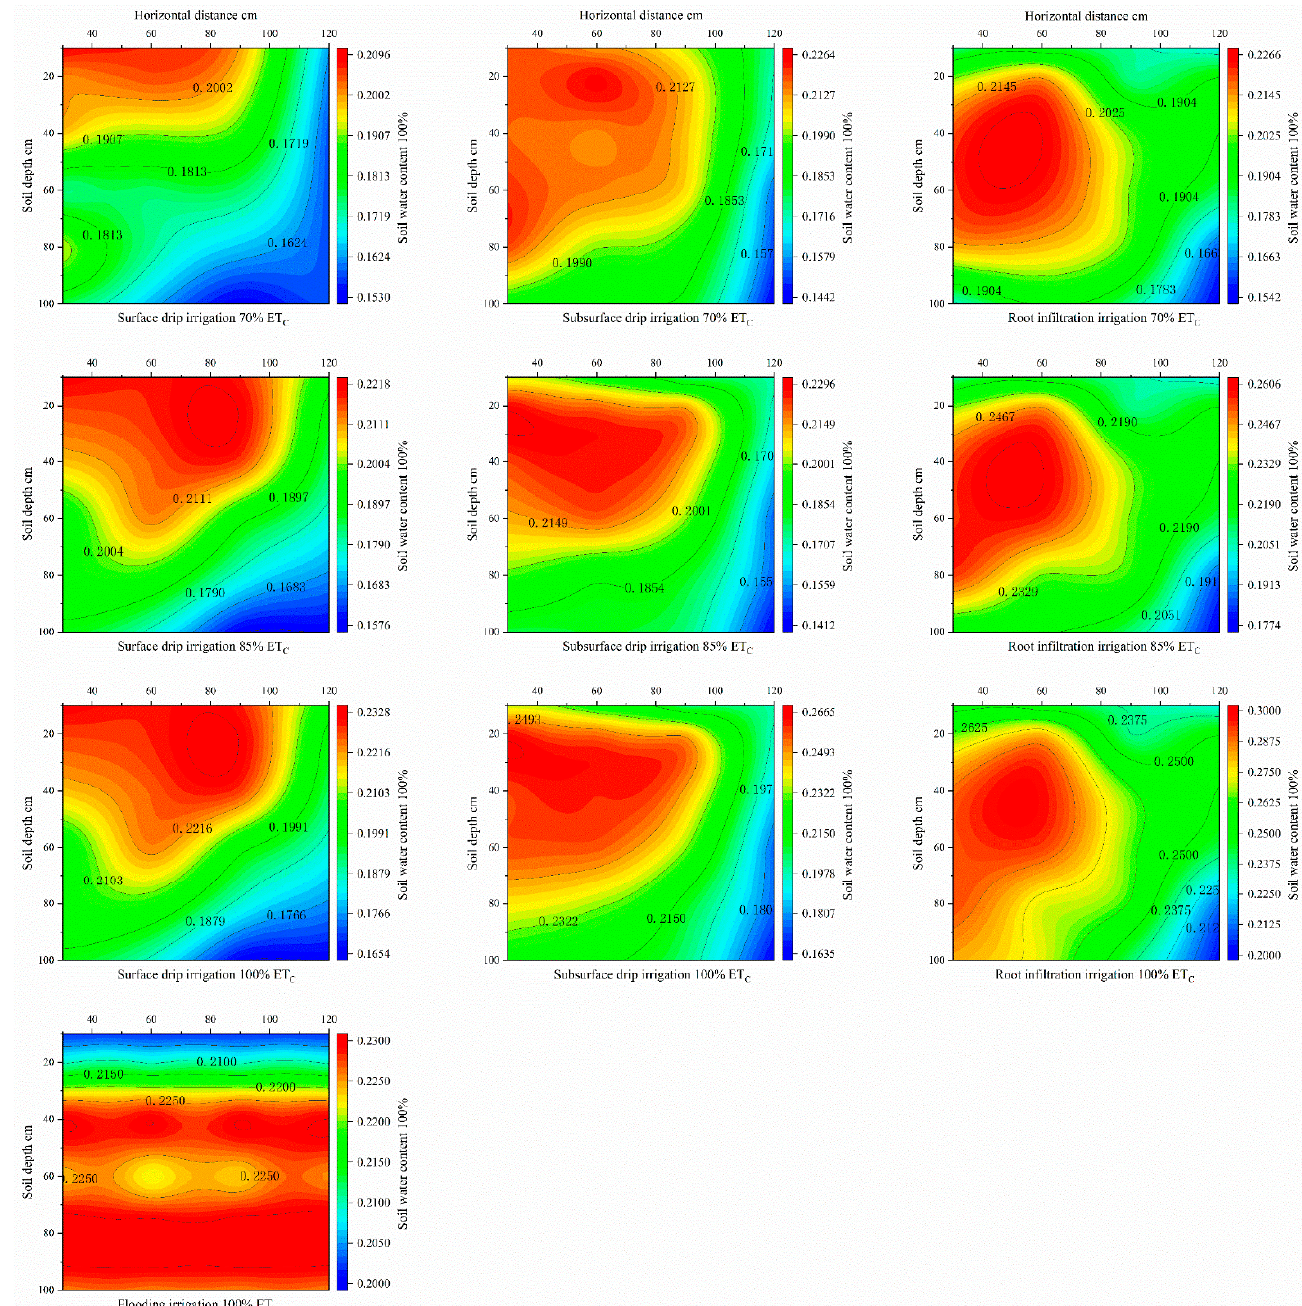
Figure 5. Distribution of soil moisture under different irrigation methods.